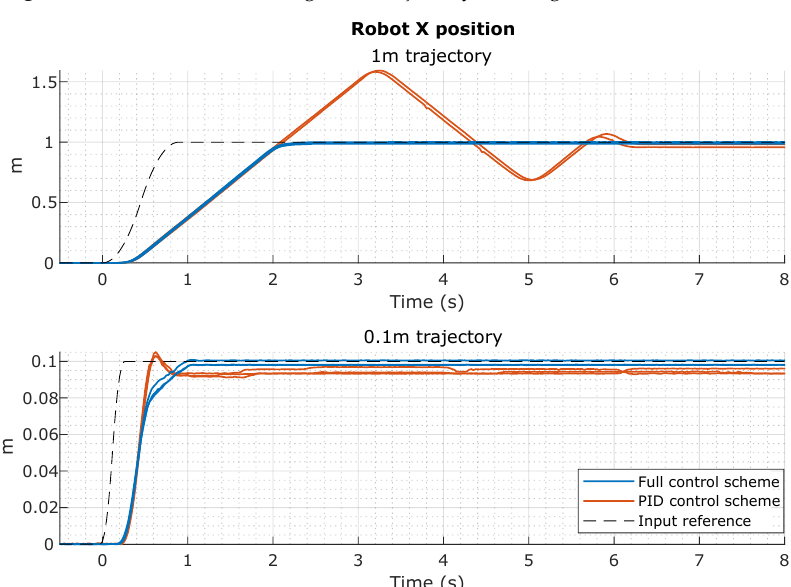
Figure 22. Robot position X results (in time) during robot trajectory